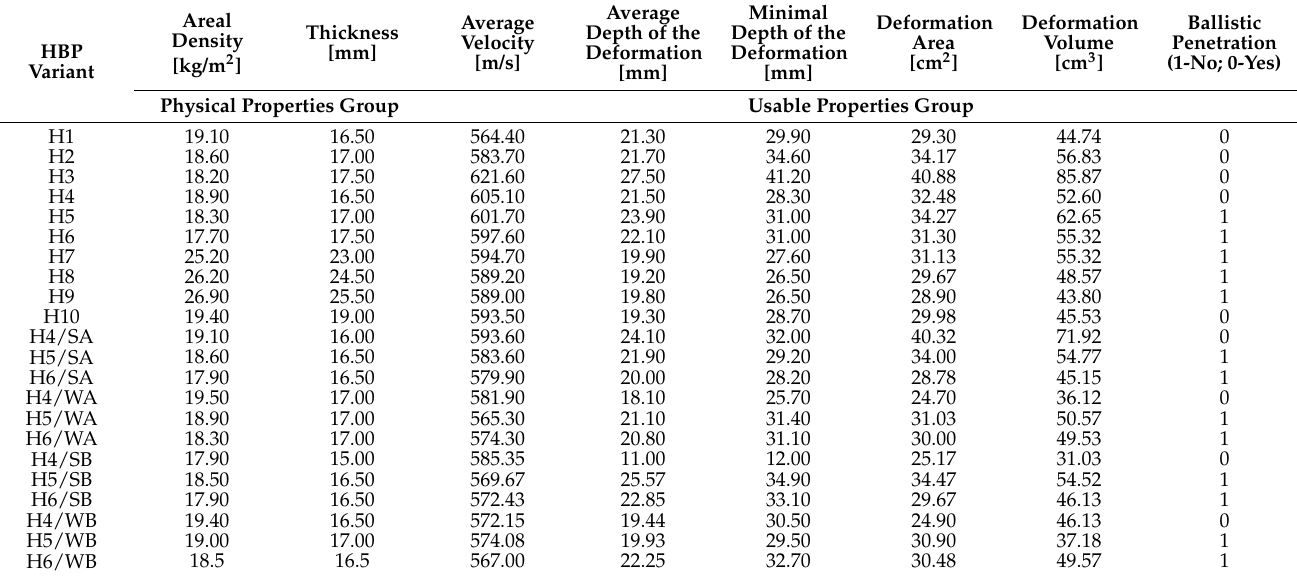
Table 6. Parameters of the designed HBP selected in two groups: physical properties and usable properties. Areal HBP Variant